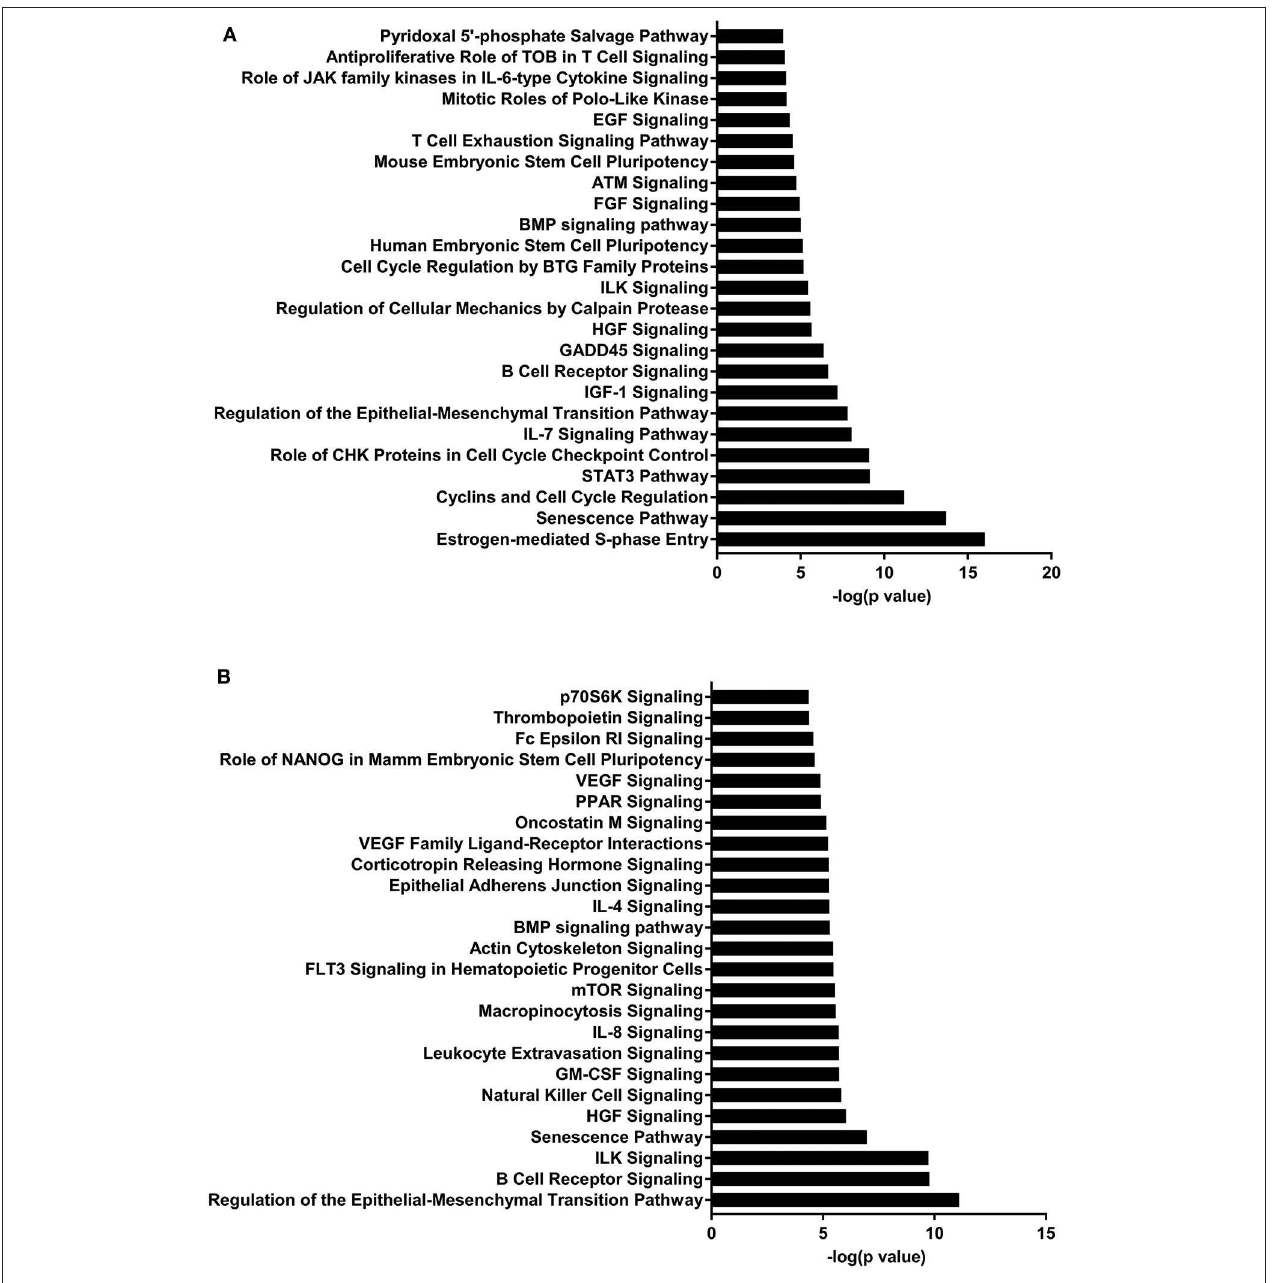
FIGURE 4 | Enriched pathways of MF compared to HM at PND51. (A) IPA of target predicted genes for downregulated miRNA in MF relative to HM at PND51. (B) IPA of target predicted genes for upregulated miRNA in MF relative to HM at PND51. The data represents from 9 MF and 10 HM fed